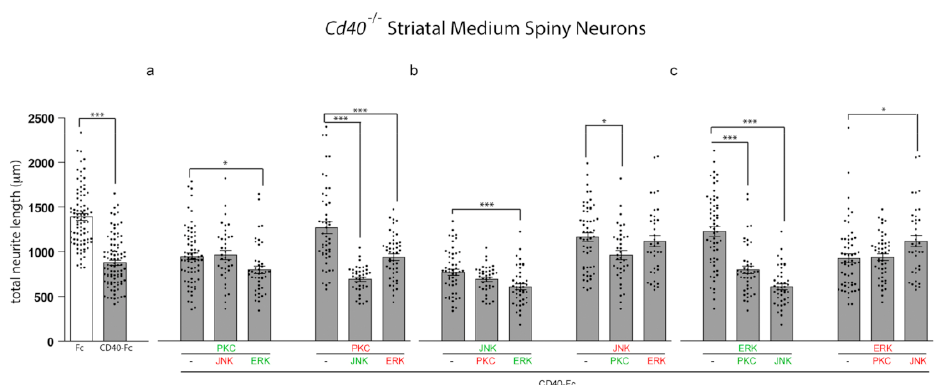
Figure 3. The influence of pharmacological reagents in combination on neurite growth from MSNs. ( a – c ) Scatter charts of total neurite lengths of MSNs of E14 Cd40 − / − embryos cultured for 10 days in vitro and treated 24 h after plating with 1 µ g/mL CD40-Fc (grey bars) plus either activators (green) or inhibitors (red) of ( a ) PKC, ( b ) JNK, or ( c ) ERK1/ERK2 in combination with the activators or inhibitors of the other two pathways (same concentrations were used as in Figure 2). For comparison, neurite lengths of neurons in cultures treated with 1 µ g/mL control Fc alone (white bars) are shown. The mean ± s.e.m of at least three independent experiments are shown. The dots represent the data obtained from individual neurons (number of neurons per condition in Supplementary